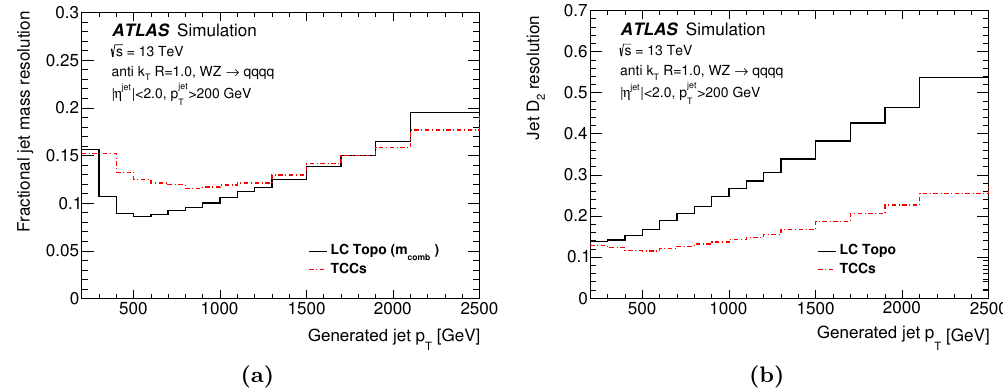
Figure 1 . A comparison of (a) the fractional jet mass resolution for jets built from a linear combination of the calorimeter and track-only mass (LCTopo m using combined and neutral Track-CaloClusters objects (dashed lines) as a function of Monte Carlo generator-level jet p . The fractional jet resolution of the D T Track-CaloClusters and pure calorimeter jets. Only the two jets with the highest p matched to a generated jet from a W or Z boson are